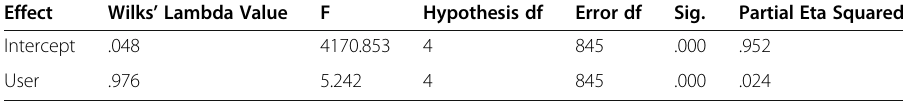
Table 6 Results of MANOVA on the four attitudinal domains